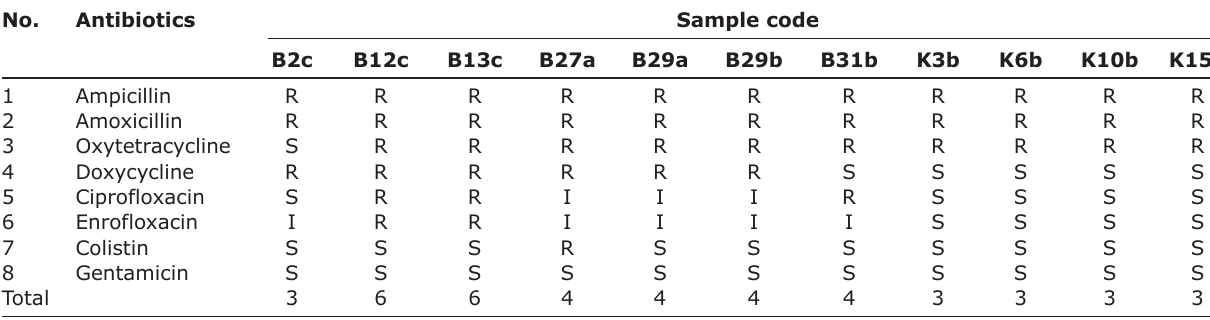
Table-2: Antimicrobial resistance pattern of Klebsiella pneumoniae .